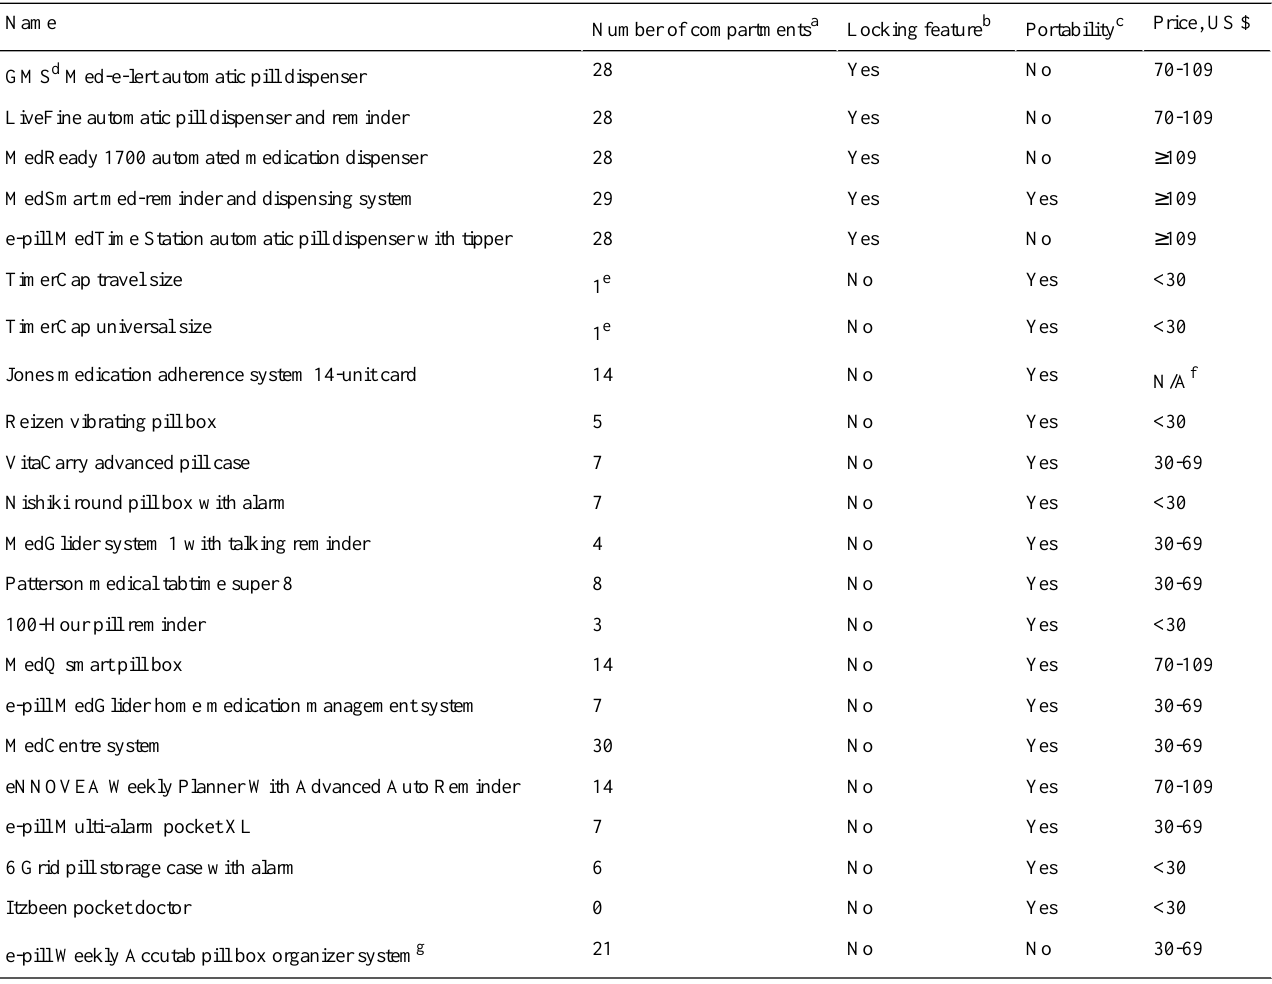
Table 1. Electronic medication adherence products used in this